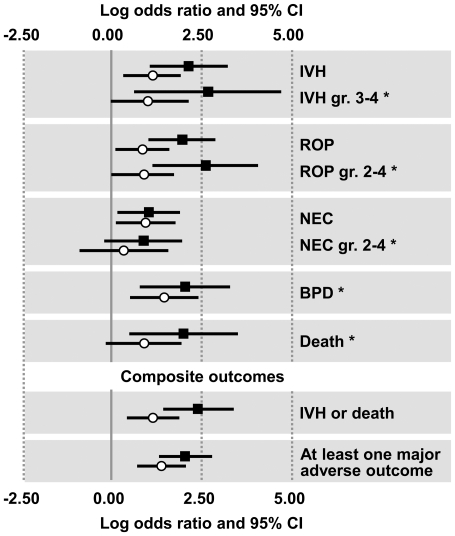
Results of 2nd-level validation against indicators of adverse neonatal outcome and impact of expressed Hp phenotype.(A) Forest plot illustrating the impact of newborn classification on prediction of neonatal complications (2nd-level validation). Open circles indicate the log odds ratios based on each newborn's clinical diagnosis of EONS. Closed squares indicate the log odds ratios based on assignment of newborns to either cluster-1 or cluster-2 based on a probability level of >50%. The length of each line shows the 95% confidence interval. The number of newborns affected by each adverse outcome and levels of statistical significance are included in Table 4. The asterisks (*) indicate major adverse outcomes taken into account in the composite variable.